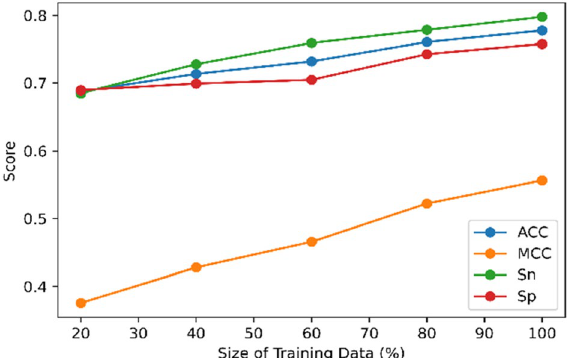
Figure 6. Sensitivity analysis of the final model on varying the size of available training